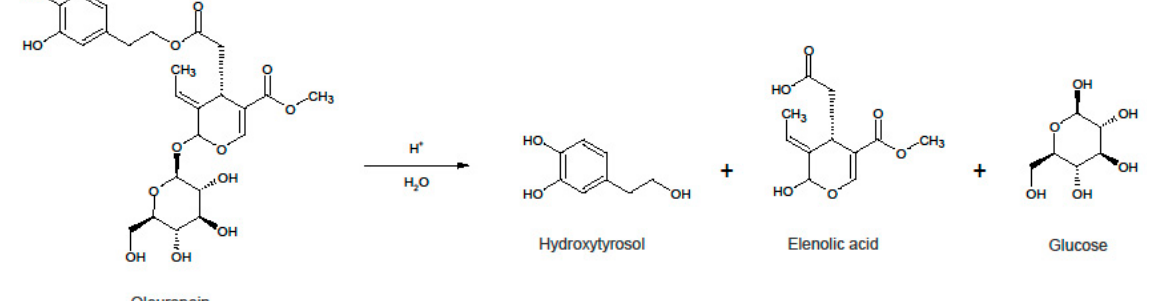
Figure 1. General reaction scheme of the acidic hydrolysis of oleuropein.